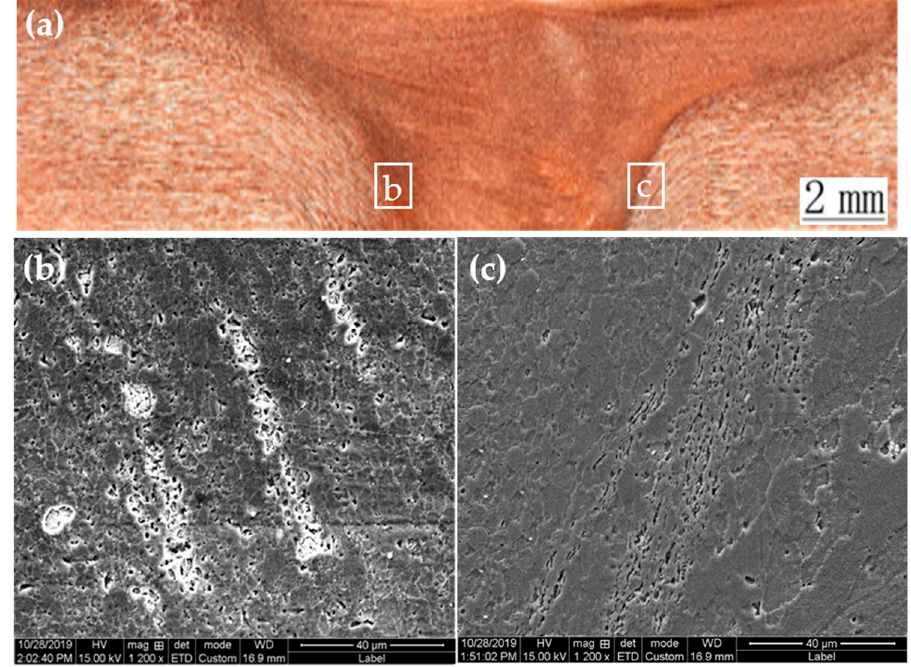
Figure 11. Defects of the FPW joint with a rotating speed of 2200 rpm and an upsetting speed of 1 mm/s: ( a ) macrograph of FPW joint, ( b ) left side, and ( c ) right side.